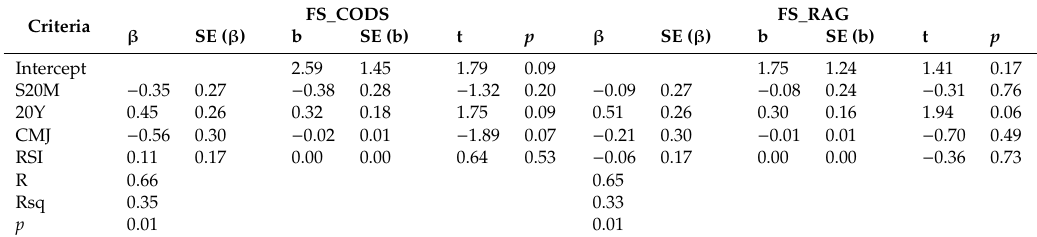
Table 6. Multiple regression calculation for the football specific change of direction speed, and football specific reactive agility (Criteria) among U15